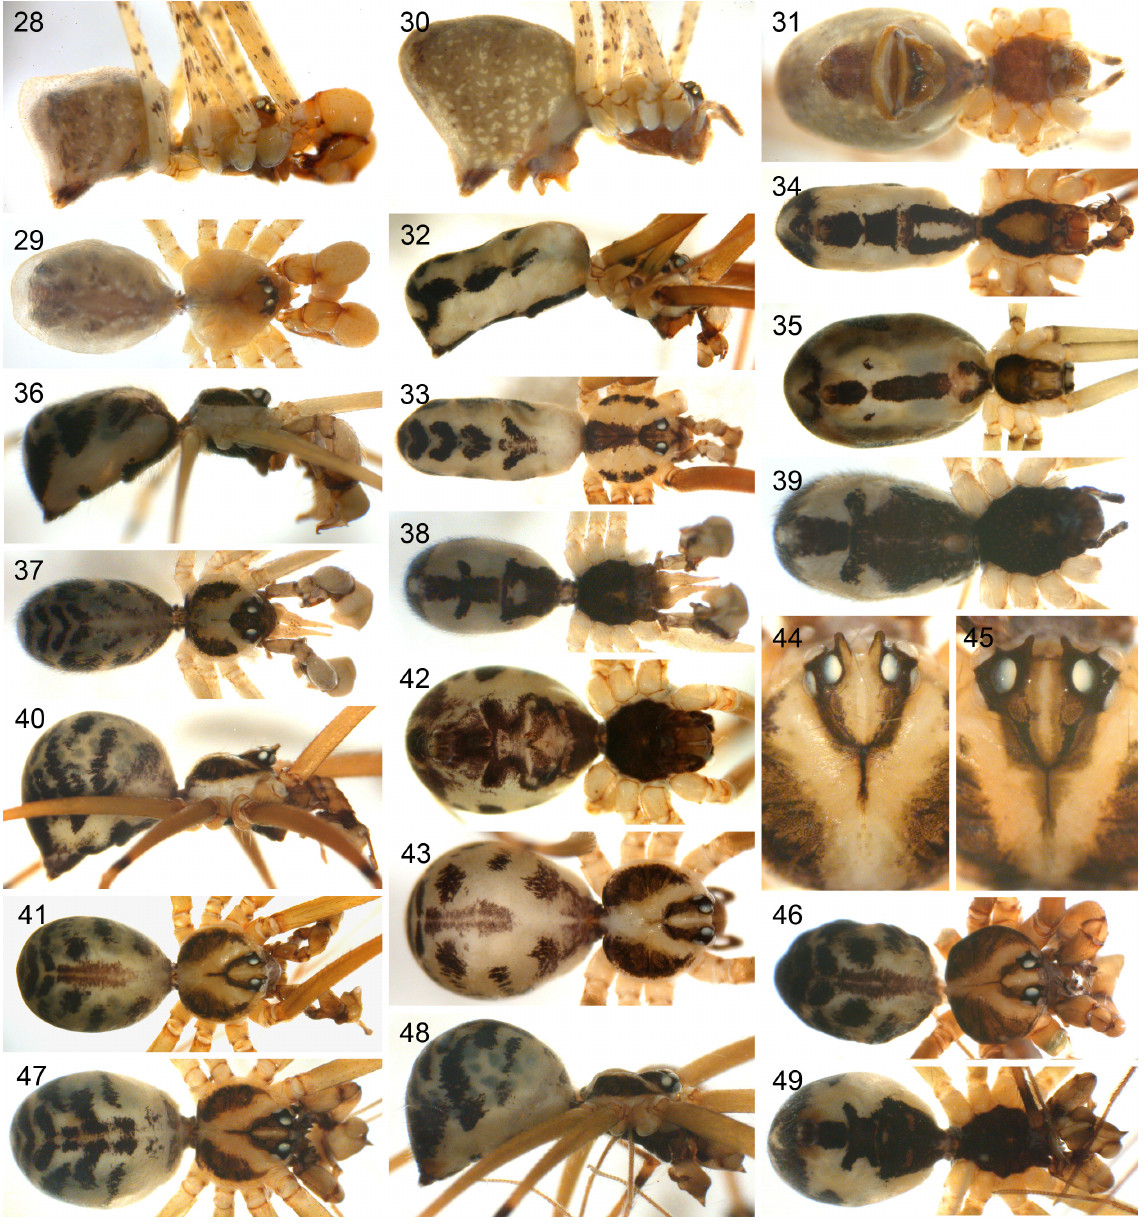
Figs 28-49. — 28-31 . Crossopriza johncloudsleyi Deeleman-Reinhold & van Harten, 2001, ♂ (28, 29) and ♀ (30, 31). — 32-35 . Buitinga wataita sp. nov., ♂ (32-34) and ♀ (35). — 36-39 . Buitinga batwa sp. nov., ♂ (36-38) and ♀ (39). — 40-44 . Spermophora mau sp. nov., ♂ (40, 41, 44) and ♀ (42, 43).— 46 . Spermophora maathaiae sp. nov., ♂. — 45, 47-49 . Spermophora bukusu sp. nov.,